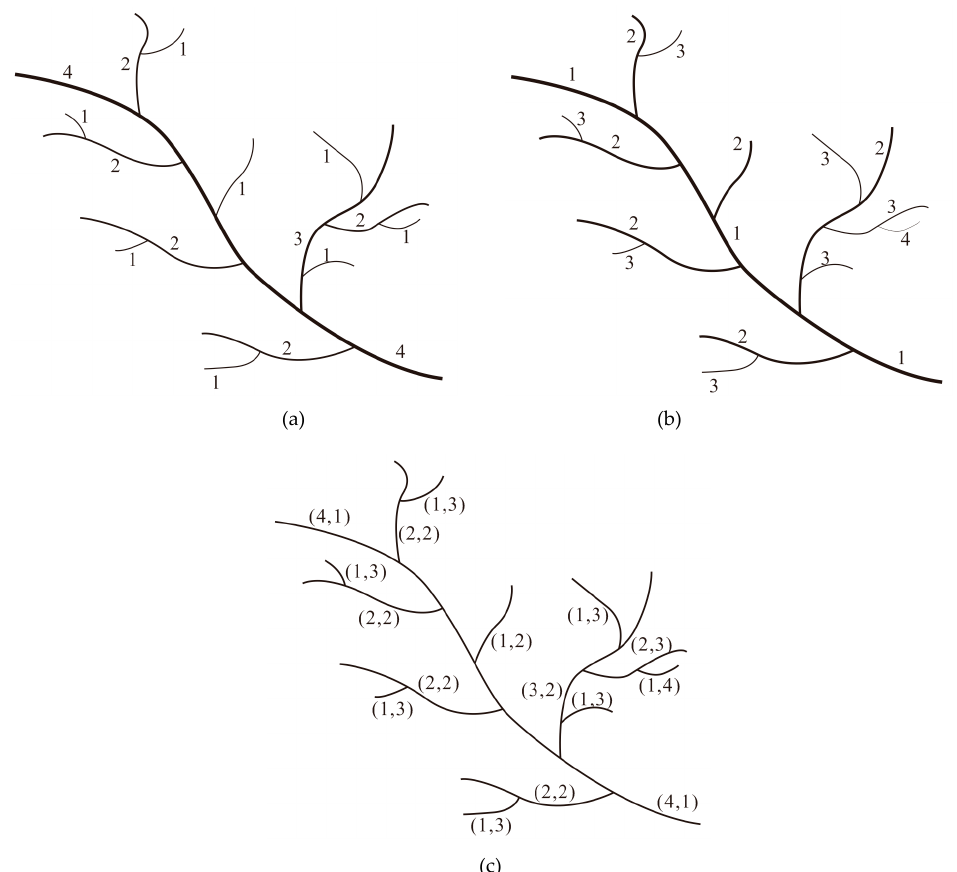
Figure 8. Three different coding methods: ( a ) top-down coding method, ( b ) bottom-up coding method and ( c ) hybrid coding method.